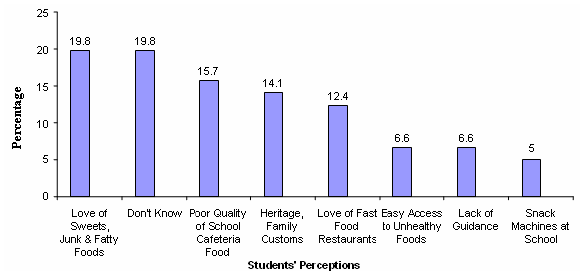
Figure 1: Students' perceptions of obstacles to better dietary practices